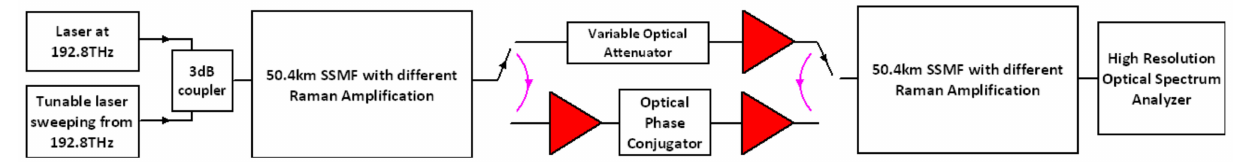
Figure 4. Schematic diagram of nonlinear product measurement using dual-order DRA in mid-link OPC systems.